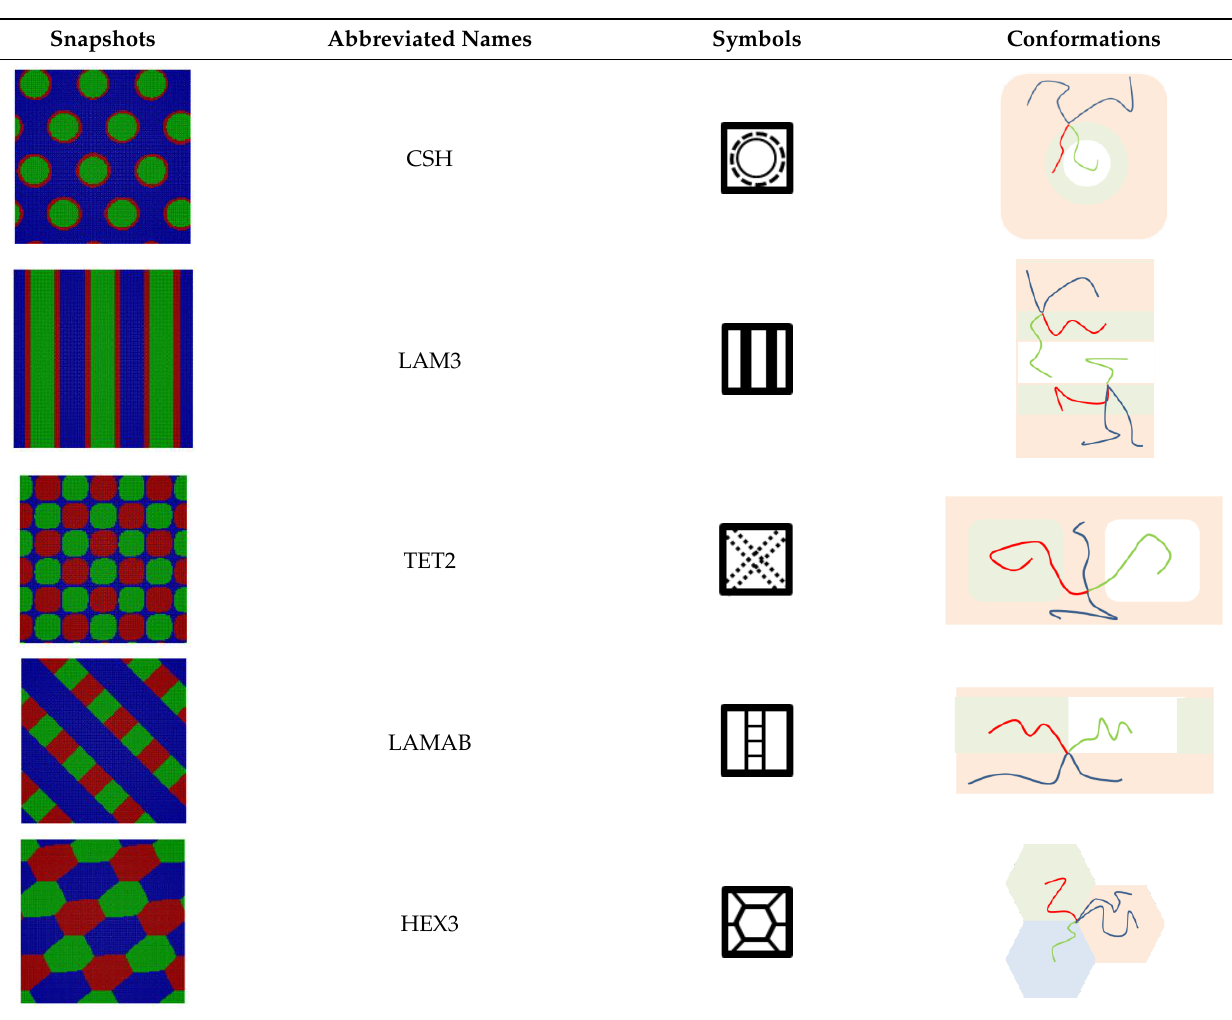
Table 1. The ordered morphologies, abbreviated names, and their symbols used in the triangle phase diagrams for the microphases of the Janus double-brush copolymers (AC 2 B) n . Using a four-arm AC 2 B star subunit as an example, the chain packing conformations in these morphologies are presented in the last column. Besides these symbols, we use to represent the “ disordered ” phase (DIS) and use to represent the “ two-color lamellar ” phase (LAM2).